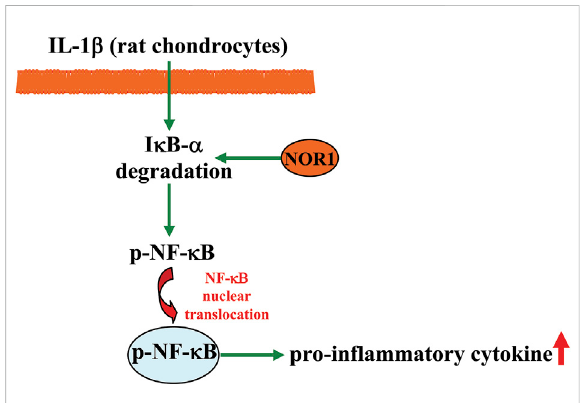
FIGURE 5 A schematic showing the regulatory effect of NOR1 in regulating in fl ammation in chondrocytes. The NOR promotes IL- 1 β -induced degradation of I κ B- α and NF- κ B nuclear translocation, thereby promoting in fl ammatory responses in rat